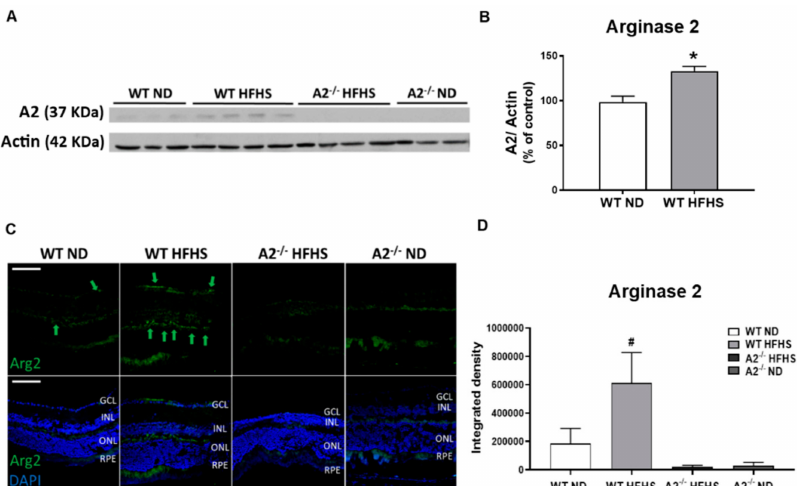
Figure 1. High-fat, high-sucrose (HFHS) diet increased retinal expression of arginase 2 (A2). Representative western blot with quantitation ( A , B ) showing elevated retina A2 protein levels in wild-type (WT) HFHS group and no A2 expression in arginase 2 knockout (A2 − / − ) animals ( n = 5–6 per group). * p < 0.05 when compared to normal diet-fed (ND) mice within the same genotype. Representative images of immunofluorescent labeling of A2 (green) in retina cross-sections at 20 × ( C ). Green arrows indicate A2 expression locations, scale bar = 50 µ m (GCL: Ganglion cell layer, INL: Inner nuclear layer, ONL: Outer nuclear layer, RPE: Retinal pigment epithelium). Quantification of A2 expression in mouse retinas ( n = 5 per group) ( D ), where # p < 0.05 when compared to animals with di ff erent genotypes on the same diet.